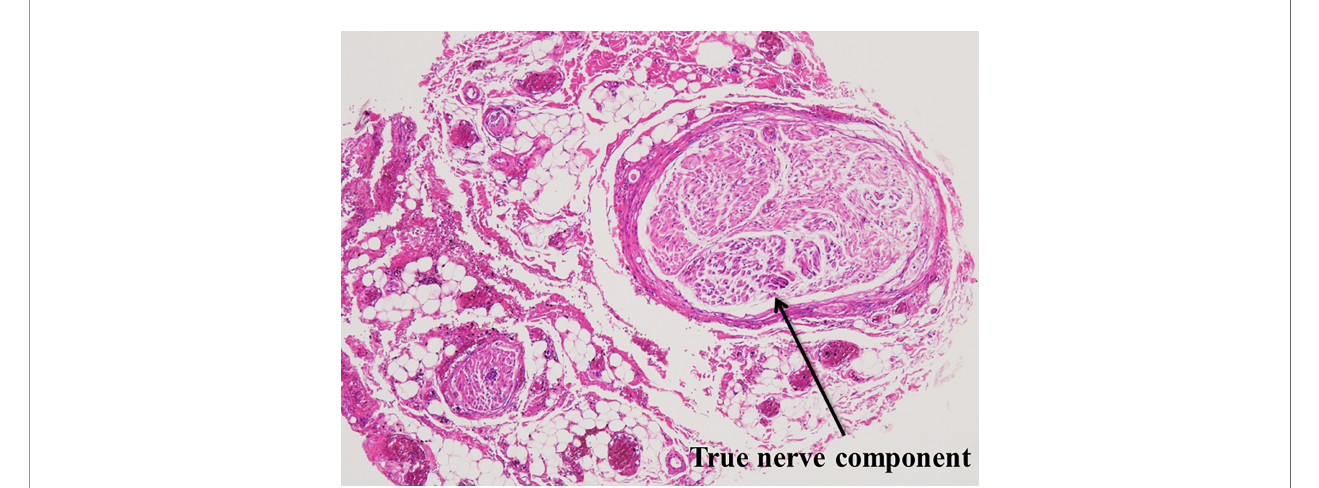
FIGURE 2 | Microscopic cross-section of the normal portion of the recurrent laryngeal nerve resected due to invasion by thyroid cancer. The true nerve component is surrounded by thick peri-neural